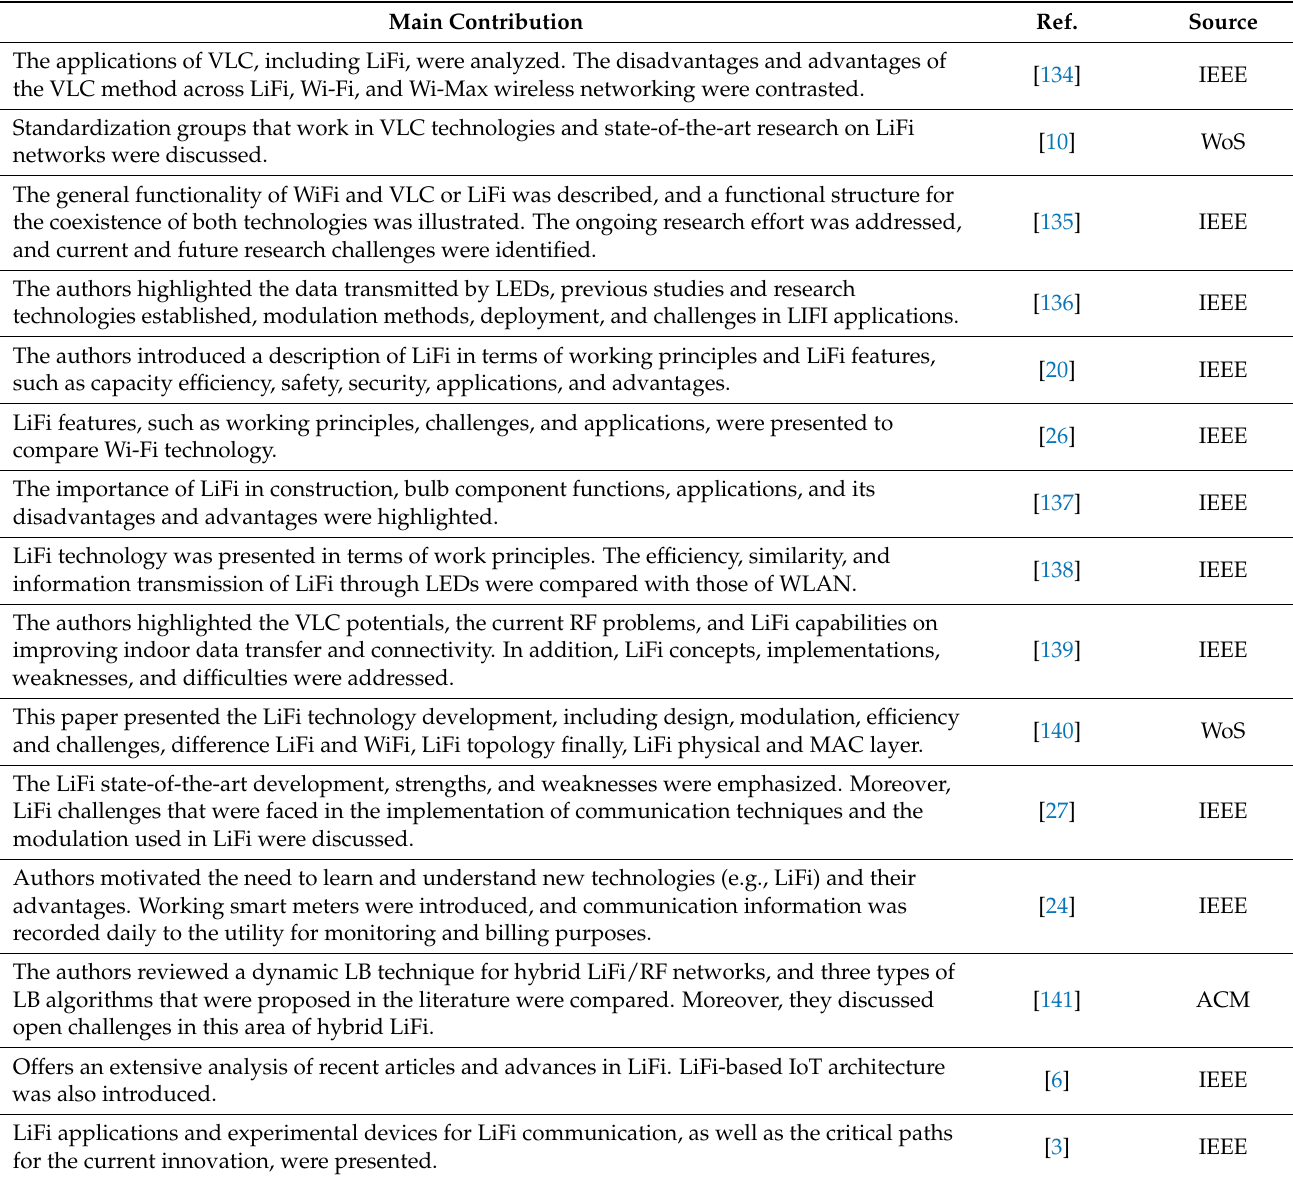
Table 2. Literature review of review and survey